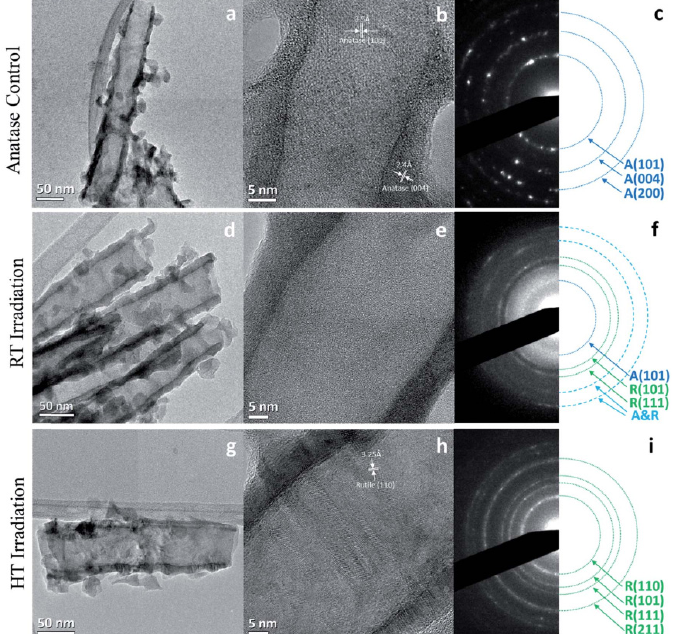
Figure 5. Low magnification TEM images of ( a ) unirradiated anatase TiO 2 nanotubes, ( d ) RT proton irradiated nanotubes, and ( g ) 250 ◦ C (HT) irradiated nanotubes, showing retained structural morphology after irradiation. HRTEM images of ( b ) unirradiated anatase TiO 2 nanotubes, ( e ) RT proton irradiated nanotubes, and ( h ) 250 ◦ C (HT) irradiated nanotubes and their corresponding SAED patterns ( c , f , and i , respectively). Reproduced with permission from ref. [43].